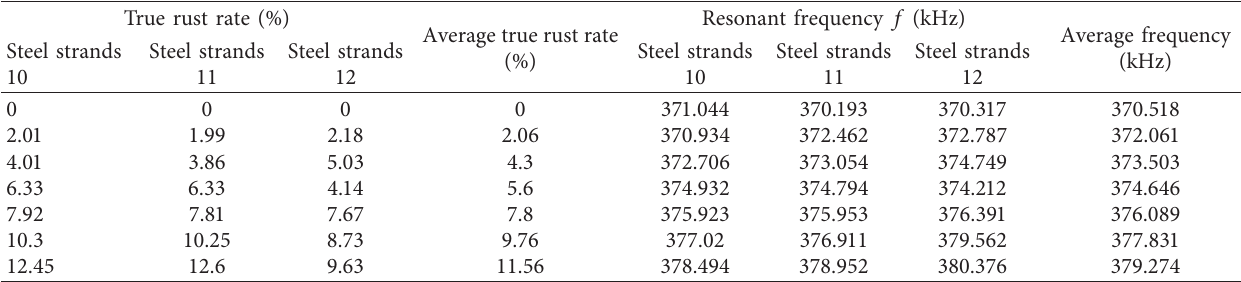
Table 6: Test data of the fourth group of steel